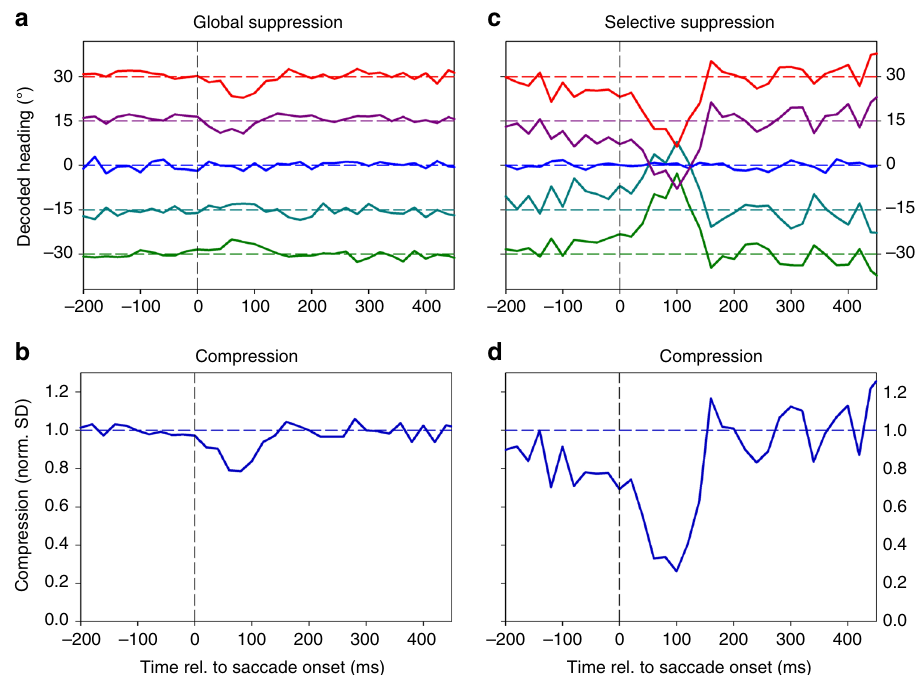
Fig. 7 Quantitative model on the role of saccadic suppression on heading decoding. We created a set of n = 71 virtual neurons, i.e., time courses of neural activity. All response properties were modeled after our real data set (see text for details). We convoluted the time courses with the response pro fi les deduced from global suppression or selective suppression, respectively (see Methods for details, and Fig. 3). We repeated this procedure 50 times for each of the two forms of saccadic suppression, i.e., global and selective, and computed the average time courses of decoded heading. When applying global suppression ( a ), there was only a marginal modulation of decoded heading shortly after the saccade. This resulted in a minimal compression ( b ). Like for the physiological data, we determined compression as normalized standard deviation of the fi ve time-courses of decoded heading. On the contrary, selective suppression, i.e., suppression of the neurons in the congruent condition combined with a release from inhibition of the neurons in the incongruent condition ( c ), triggers a compression of decoded heading, with a maximum of suppression around 100 ms after saccade onset ( d